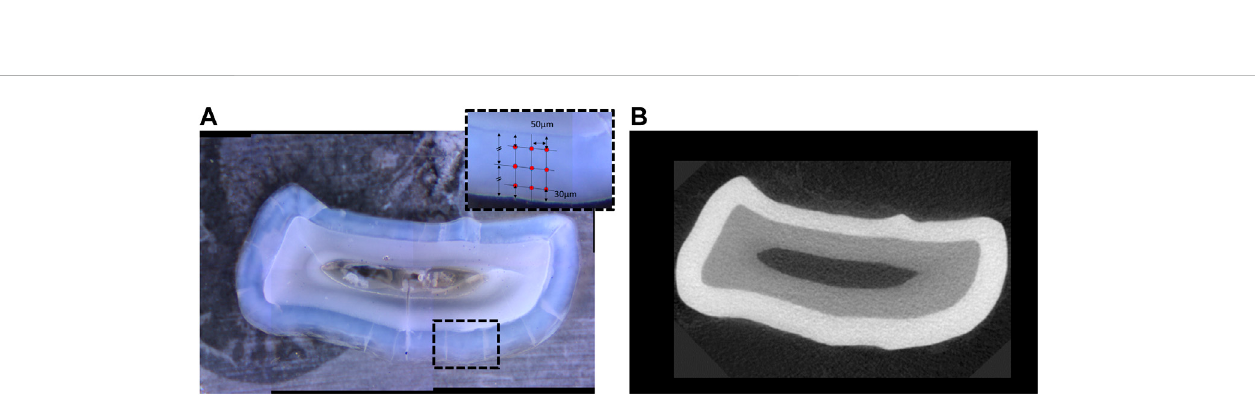
FIGURE 3 (A) Transversesectionofamandibularincisoratthelevelofgingivalemergence,withinsetinpanelrepresentingthelocationoftheindentsofthemicro- indenter in one of the four quadrants of the cross-section. (B) Corresponding image of the same tooth in a virtual section at the level of gingival emergence from the microCT tomogram (right) showing mineral